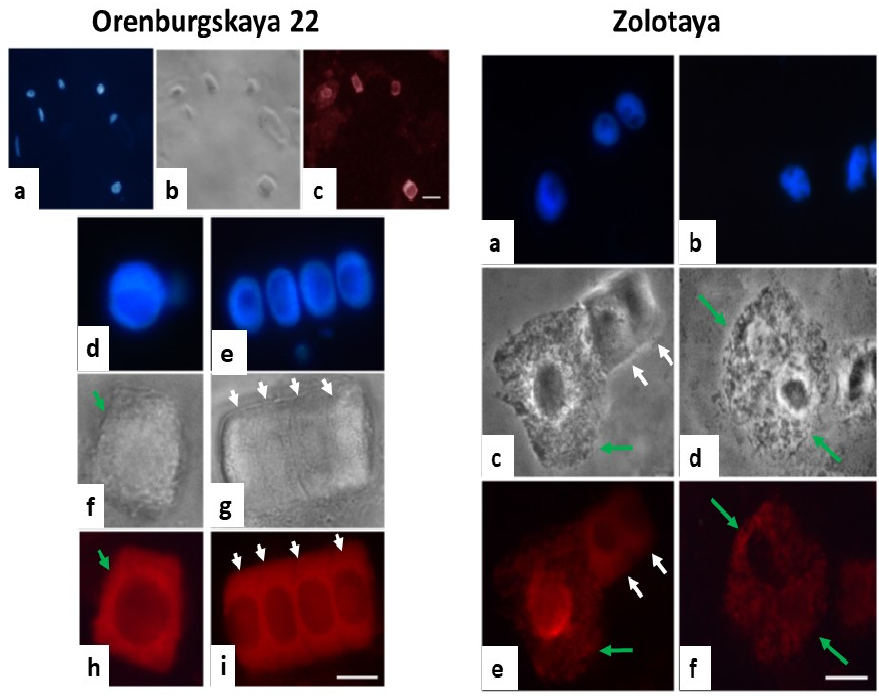
Figure 9. DNA breaks in the nuclei of cell tissues of the roots of 4-day-old seedlings in the presence of 150 mM NaCl, detected by the TUNEL method in Triticum aestivum variety Orenburgskaya 22: ( a , b , g )—root cell nuclei (DAPI); ( c , d , h )—phase contrast of cells; and ( e , f , i )—nuclei, micronuclei (arrows—white), and chromosomes with DNA breaks (arrows—green); and in Triticum durum vari- ety Zolotaya, ( c )—nuclei of root tissue cells (DAPI); ( c , d )—nuclei with DNA breaks (arrows—green), Bar 200 μ m.